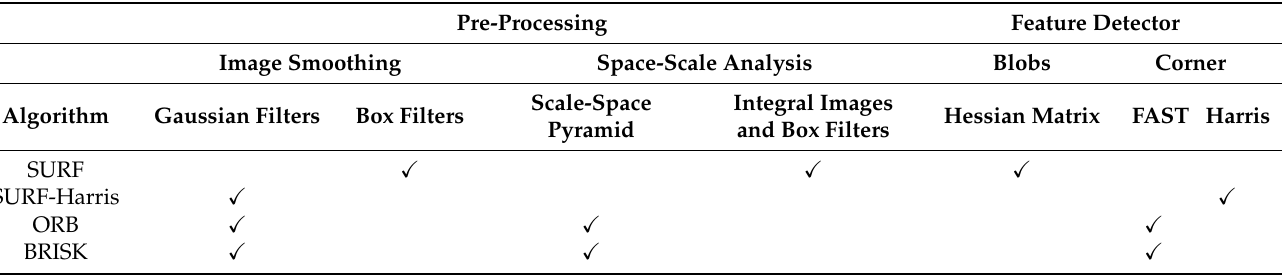
Table 1. Characteristics of the selected feature detection